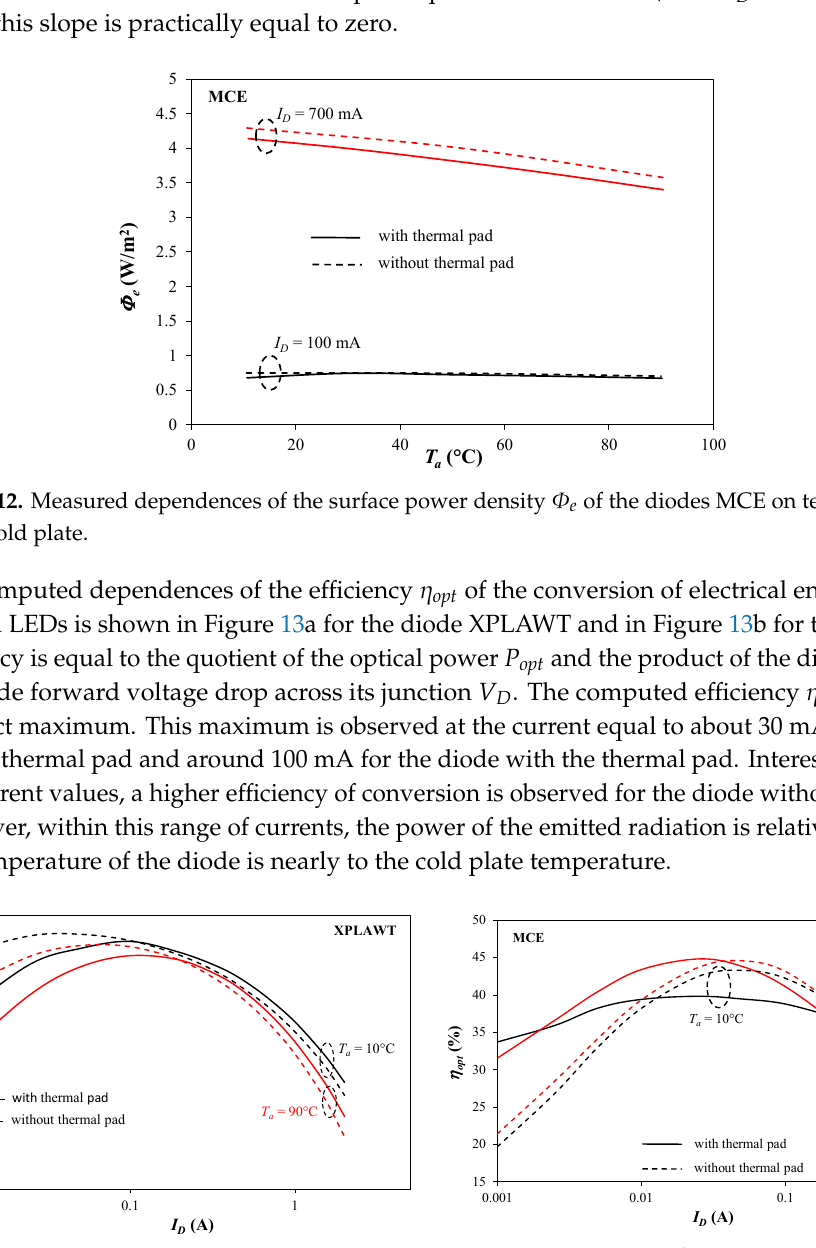
Figure 11. Measured dependences of the surface power density change ΔΦ e of the diodes MCE on forward current.